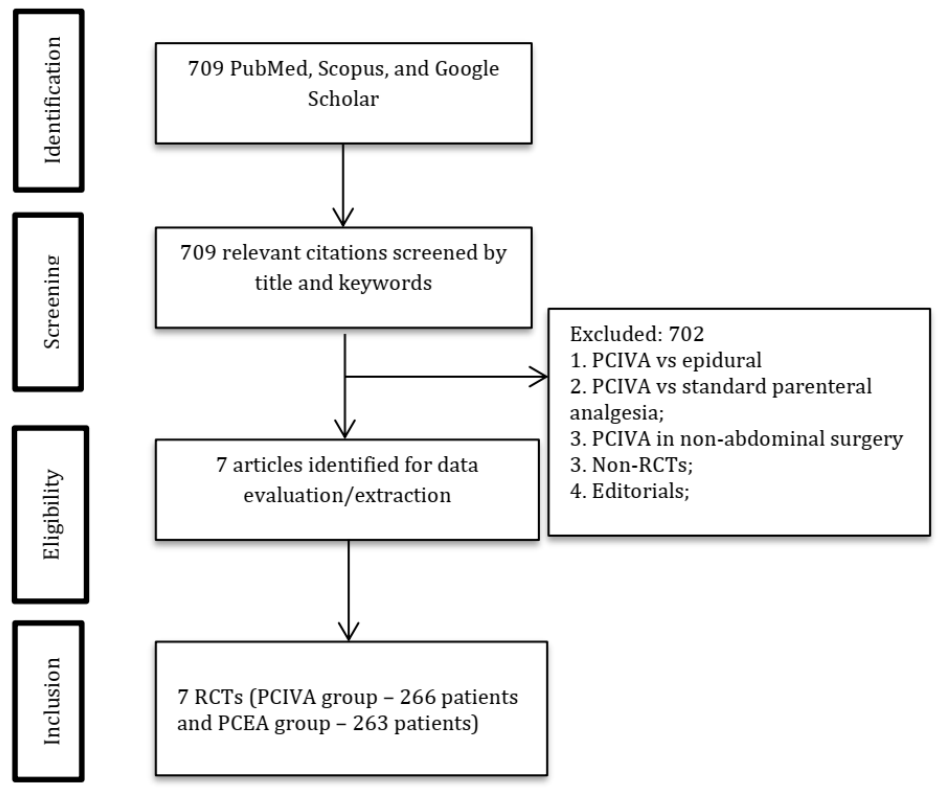
Figure 1. PRISMA diagram. Abbreviations: PCIVA, patient-controlled intravenous analgesia; PCEA, patient-controlled epidural analgesia .